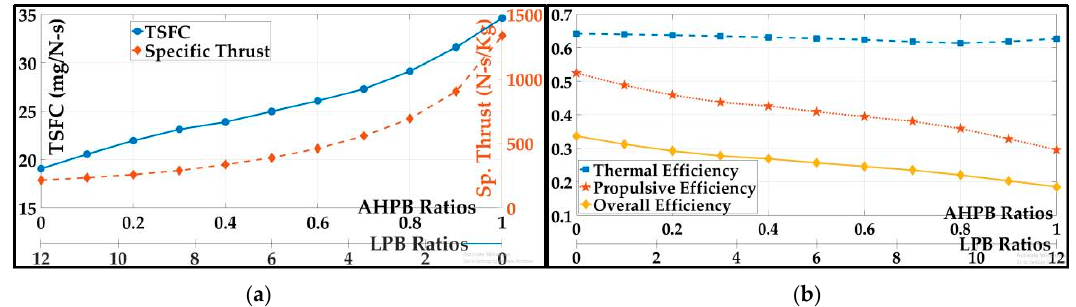
Figure 3. Plots of ( a ) thrust-specific fuel consumption (TSFC) vs. specific thrust and ( b ) efficiencies as a function of bypass ratios.